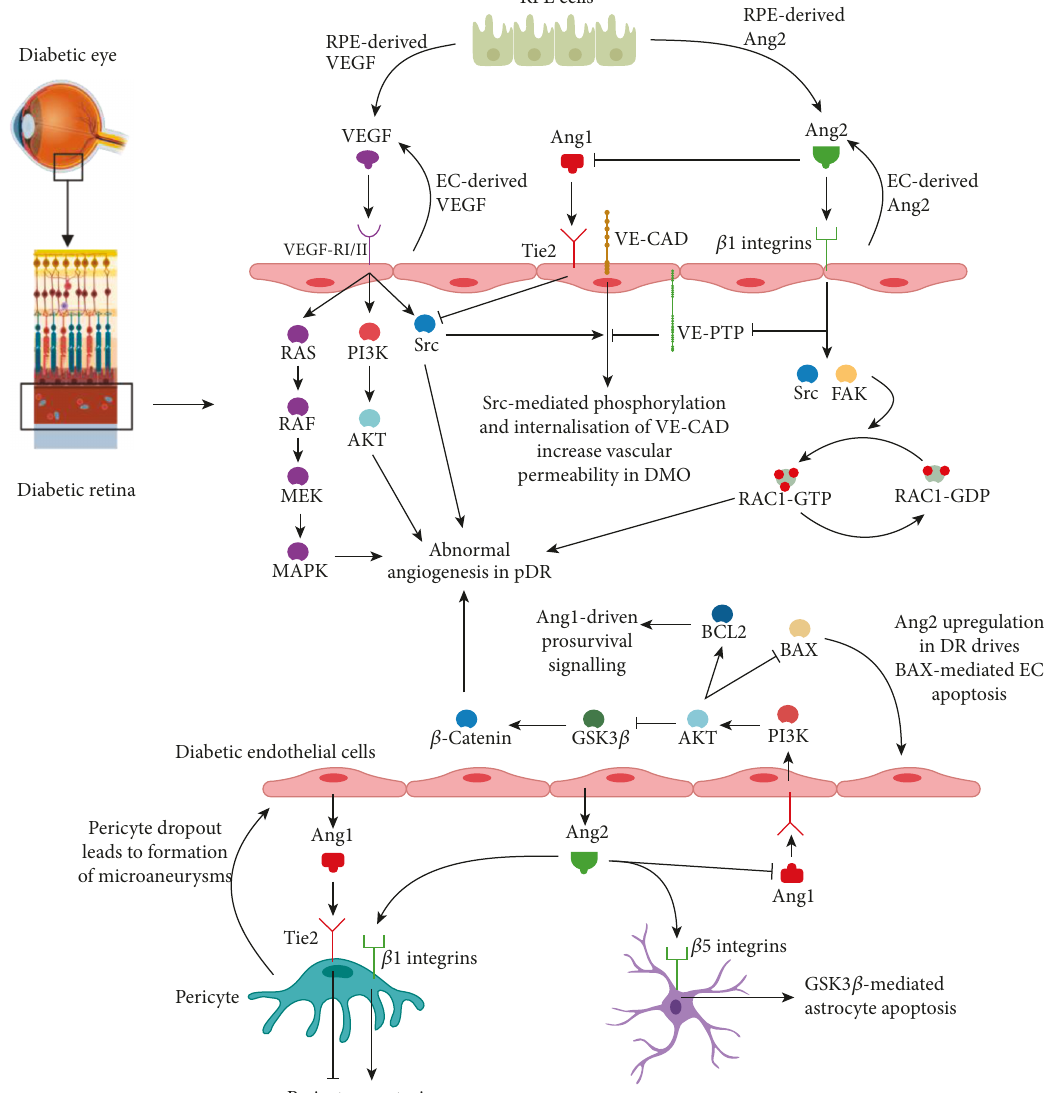
Figure 1: Overview of Ang/Tie2 signalling in the diabetic eye, including crosstalk with the VEGF pathway. EC =endothelial cell;